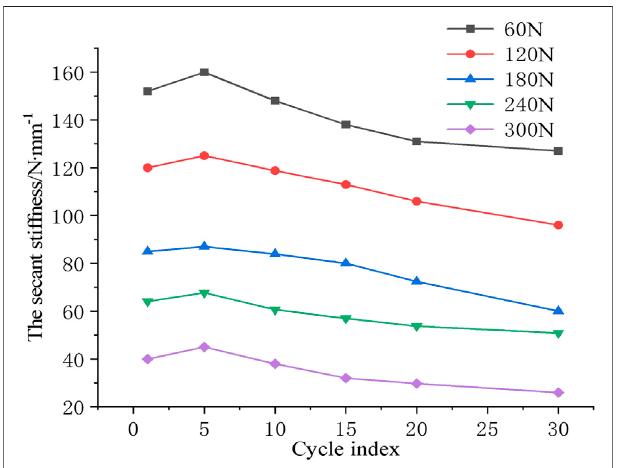
FIGURE 15 | Relationship curve between secant stiffness and the number of cycles.